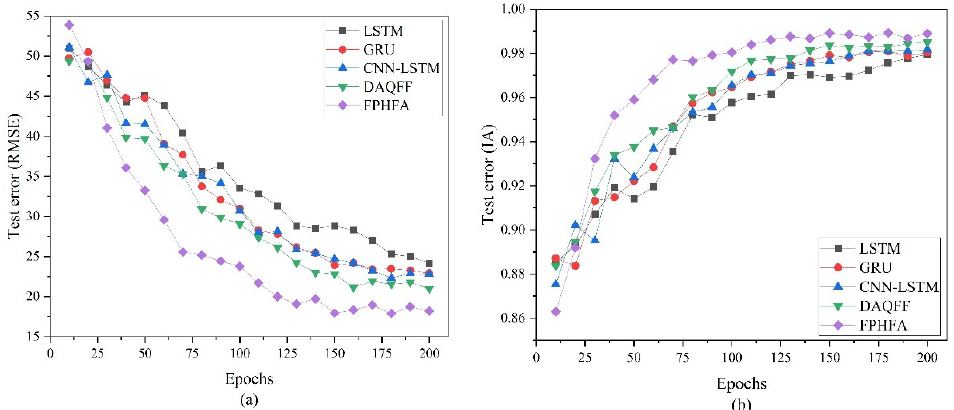
Figure 8. Window size is 56, prediction length is 12 h, and batch size is 128. Effect of number of epochs on RMSE and IA of models in the Beijing dataset. ( a ) RMSE, ( b ) IA.